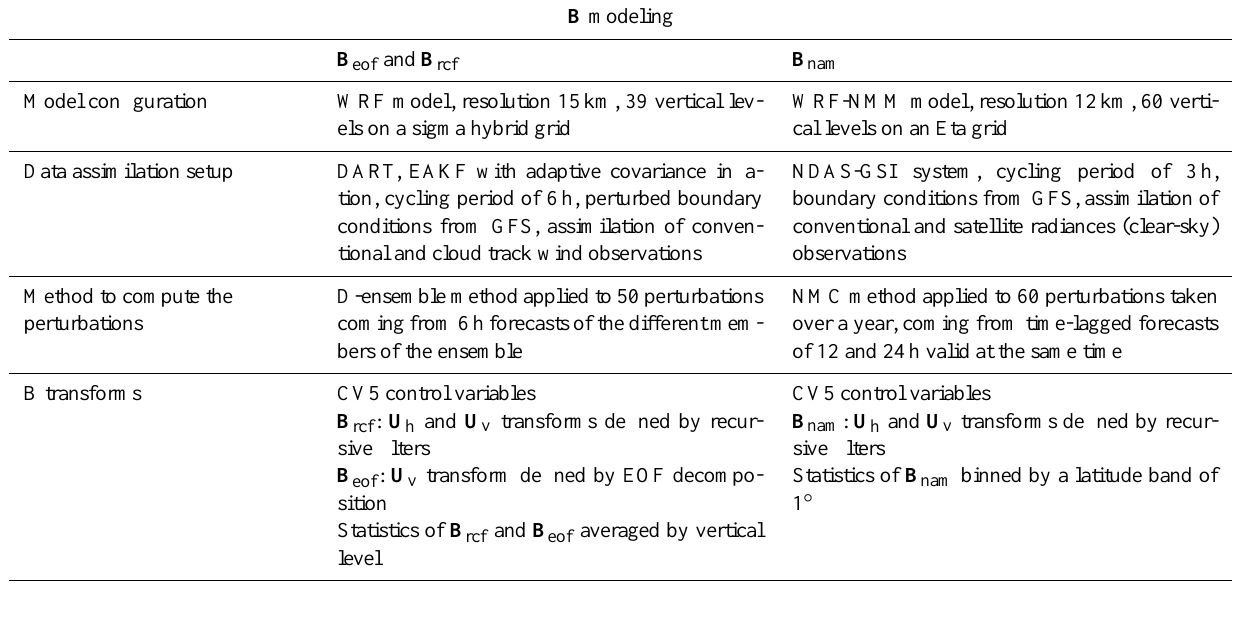
Table 2. Description of the setup of the background error matrix modeling diagnosed over the CONUS domain. B eof and B rcf are diagnosed using GEN_BE code version 2.0 and the D-ensemble method, while B nam is performed by NCEP using the NMC method.